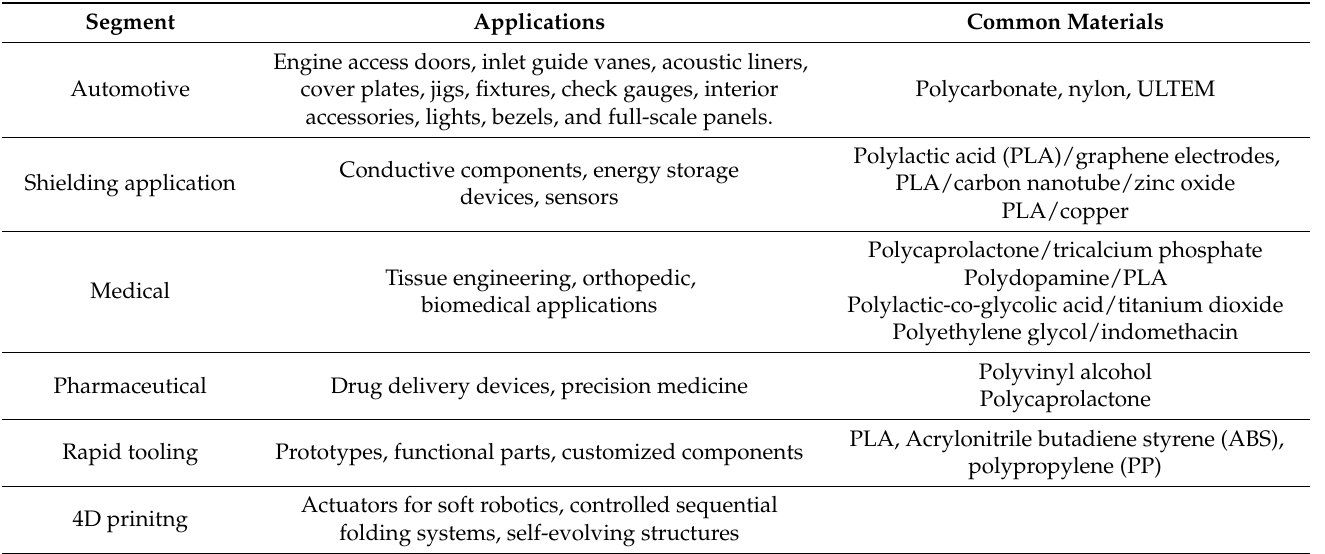
Table 1. Applications of FDM